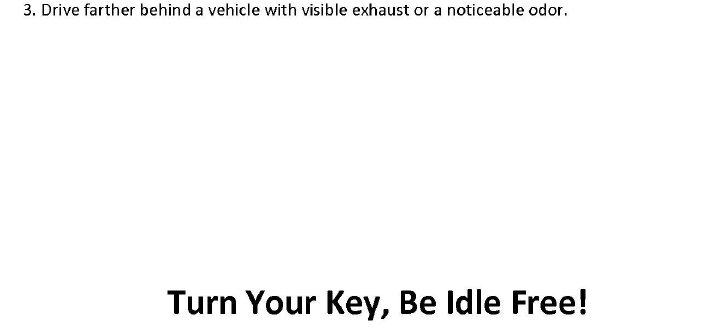
Figure A13. Idle-free schools policy for bus drivers.